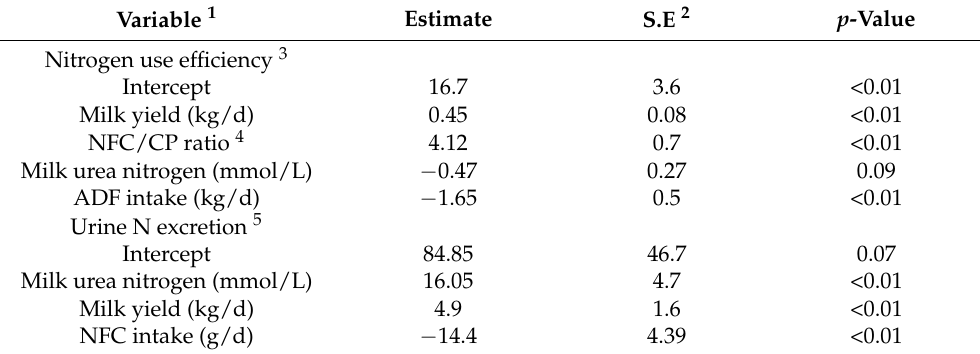
Table 7. Variables influencing the nitrogen use efficiency and urinary N excretion for Chilean Dairy cattle.